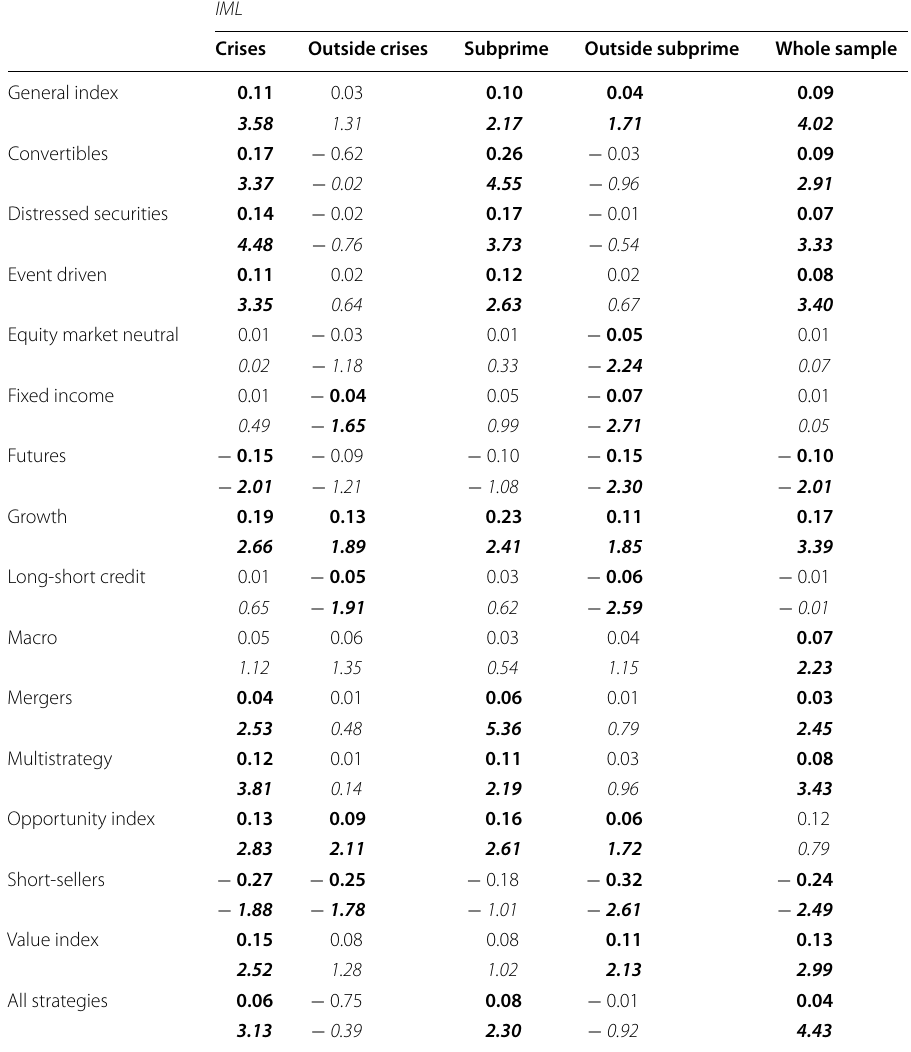
Table 4 Sensitivities of hedge fund strategies’ returns to IML using pooled regressions with fixed coefficients and SUR,